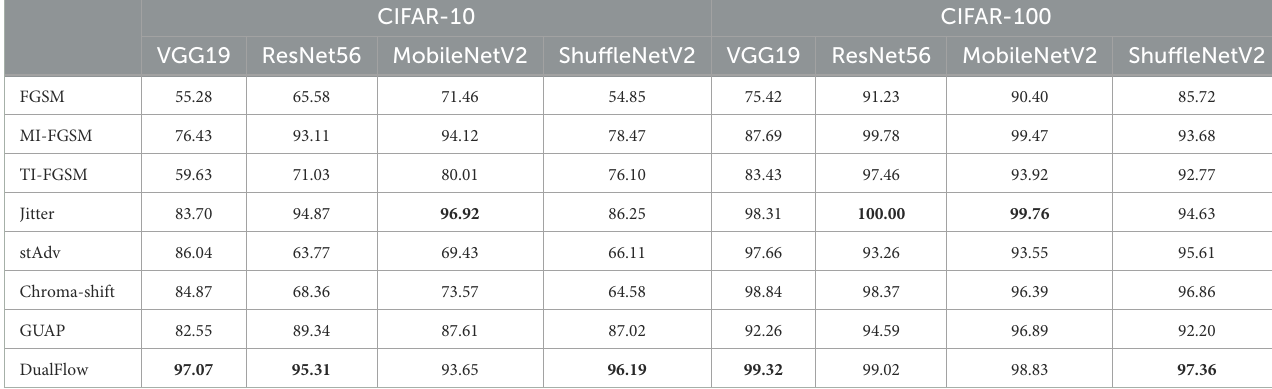
TABLE 2 Experimental results on attack success rate (ASR) of un-targeted attack of CIFAR-10 and CIFAR-100.